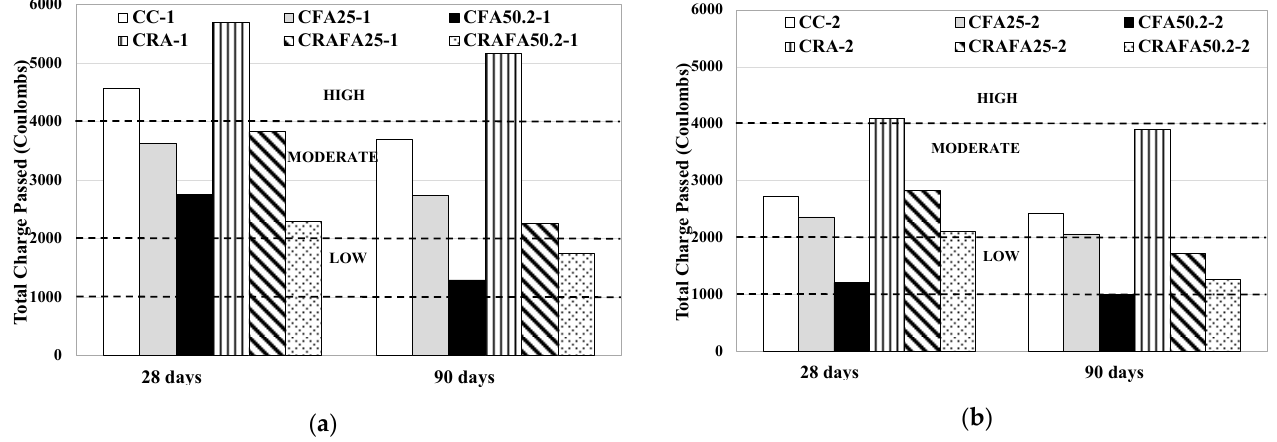
Figure 9. Chloride-ion penetration of concrete mixtures and ASTM corrosion ranges. ( a ) Series 1, ( b ) Series 2 concrete.